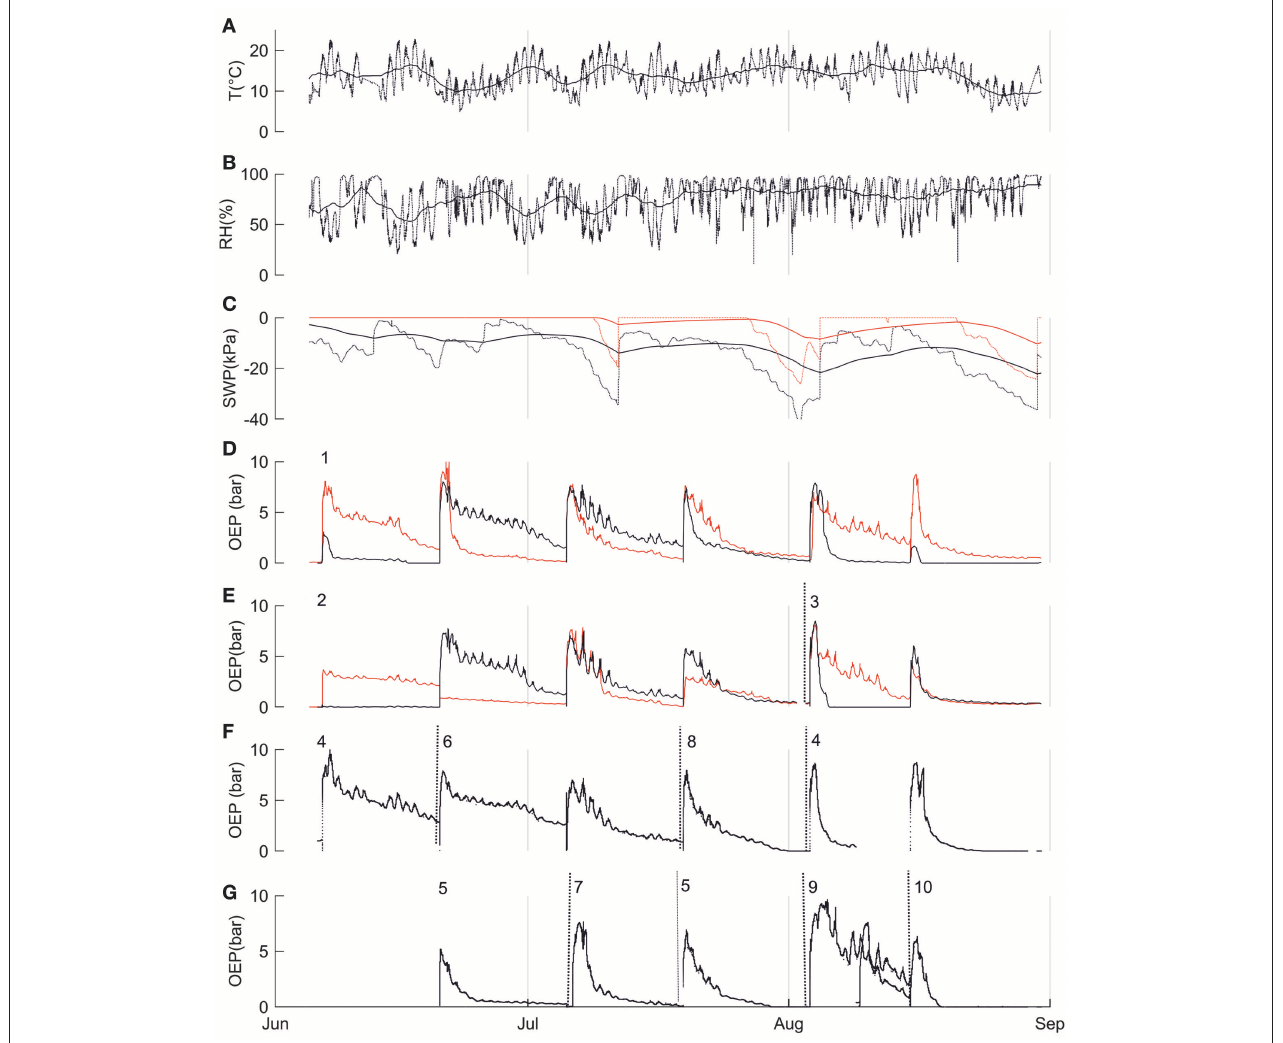
FIGURE 3 | Environmental and physiological parameters from the SMEAR II site and three mature Scots pines (Trees 1, 2, and 3) in summer 2017. In A-D : (A) ambient temperature at 16m, (B) relative humidity at 16m, (C) soil water potential of the A horizon (black line) and B horizon (red line). Solid lines in (A-C) represent five-day means; dotted lines represent the diurnal dynamics. In (D-G) oleoresin exudation pressures (OEP) of trees indicated with numbers (D) OEP in the top (red line) and bottom parts (black line) of the stem of Tree 1, (E) OEP in the top (red line) and bottom parts (black line) of the stem of Tree 2 until the end of June and Tree 3 in August (change marked with dotted line), (F) OEP in the bottom parts of trees 4, 6, and 8, change of the measurement tree indicated with dotted line, (G) OEP in the bottom parts of trees 5, 7, 9, and 10, change of the measurement tree indicated with dotted line, Note: OEP increased abruptly whenever the pressure transducer was relocated (relocation was done due to resin crystallization), referring to measurement